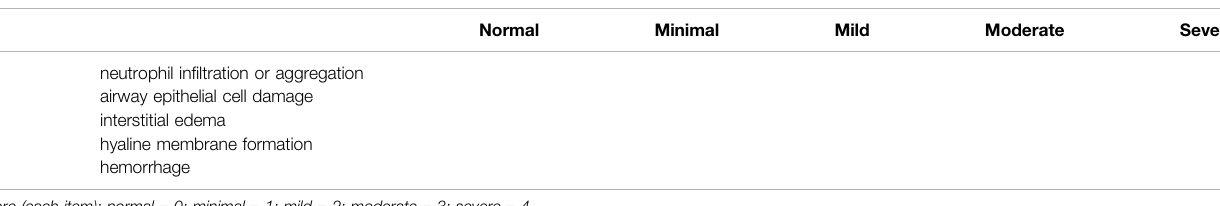
TABLE 1 | Lung injury score (LIS) Pirat et al.,